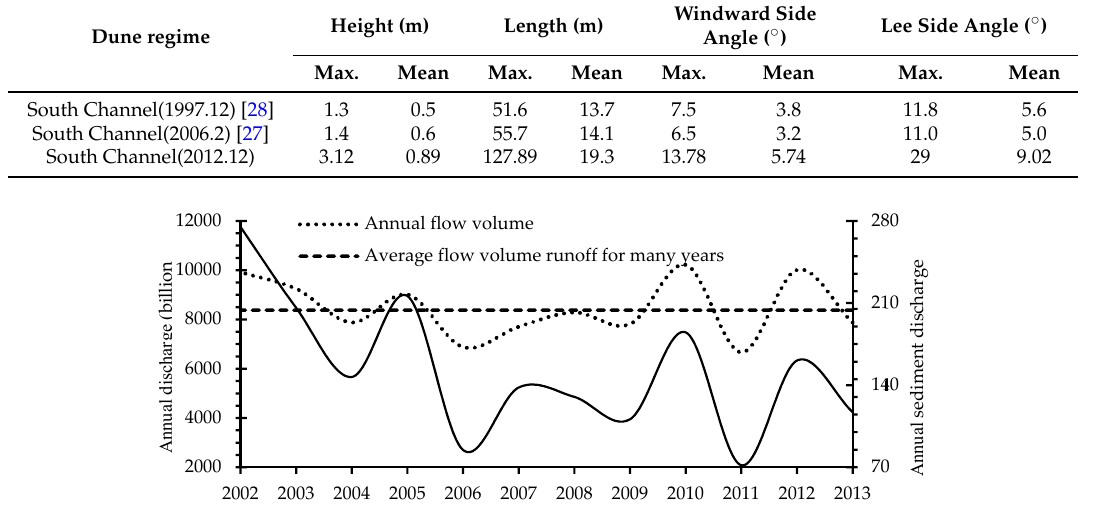
Figure 7. Change of the annual flow volume and suspended sediment yield in recent years at the Datong station on the Yangtze River estuary.